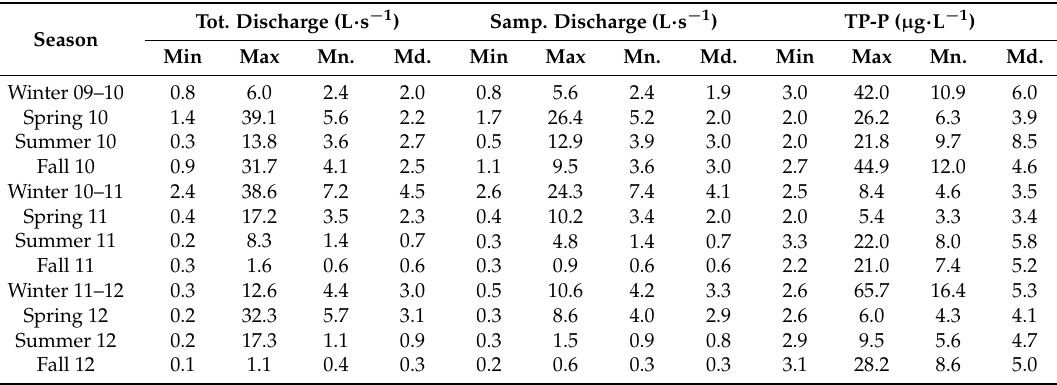
Table 2. Overview of discharge during the whole period (Tot. Discharge), the sampled discharge (Samp. Discharge), and total phosphorus (TP-P) concentrations during the fixed-schedule sampling for the different seasons; with Min = Minima, Max = Maxima, Mn. = Mean, Md. = Median.